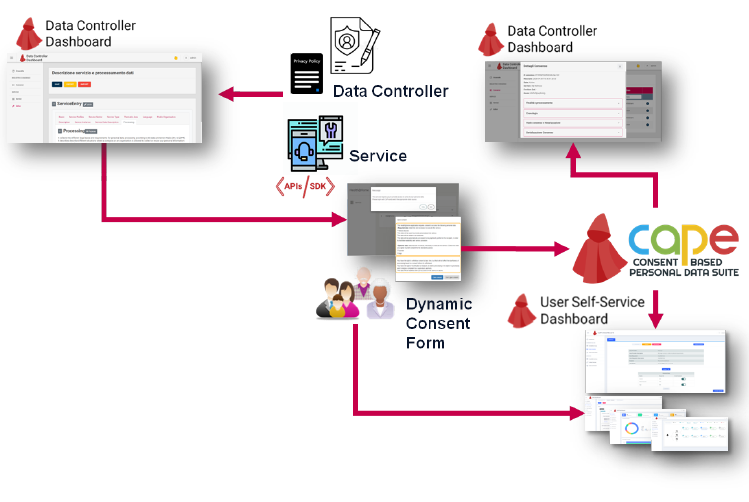
Figure 6. How CaPe